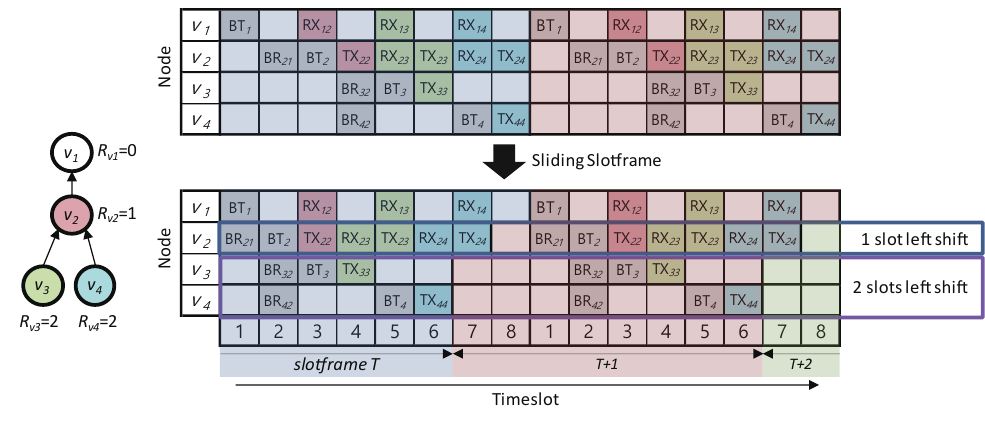
Figure 3. An example of the sliding slotframe.